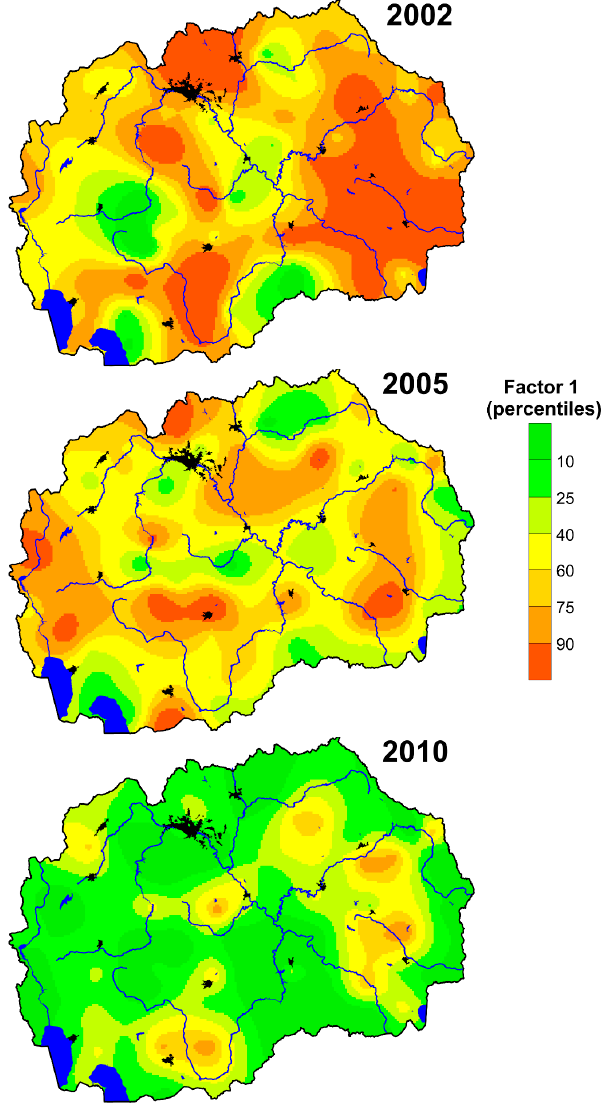
Figure 6. Spatial distribution of F1 factor scores (Al-As-Co-Cs-Fe-Hf-Na-Rb-Sc-Ta-Th-Ti-U-V-Zr-RE*).